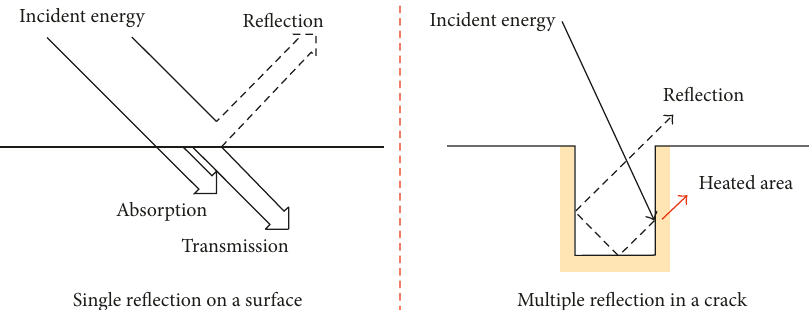
Figure 1: Multiple reflections of light in a crack.